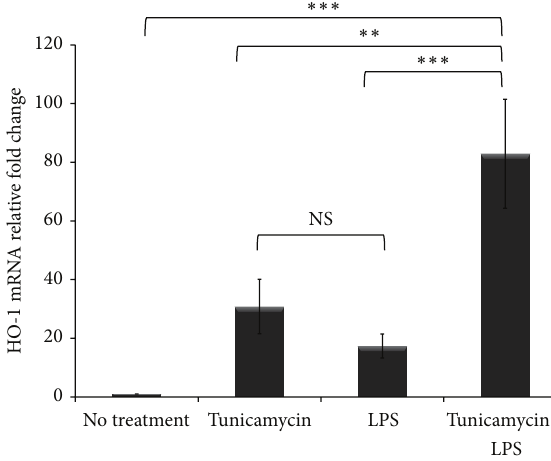
Figure 6: ER stress and inflammation induce heme oxygenase- 1 (HO-1) gene expression in macrophages. THP-1 cells ( 1 × 10 6 cells/mL) were treated with tunicamycin (10 𝜇 g/mL) or DMSO overnight prior to LPS exposure (40 ng/mL) for 6hr. RNA was extracted and HO-1 gene expression was assessed by quantitative RT-PCR normalized to 𝛽 -actin. The fold change in OH-1 gene expression was calculated in reference to DMSO treated control THP-1 cells using the ΔΔ CT method and presented here normalized to no treatment control. Error bars represent the SD from the mean of three independent experiments. 𝑃 values were calculated in reference to vehicle treatment using one-way ANOVA followed by Bonferroni multiple comparisons post hoc analysis. 𝑃 values annotated ∗∗∗ 𝑃 < 0.0001 ; ∗∗ 𝑃 = 0.001 – 0.01 ; 𝑃 > 0.05 were not significant (NS).